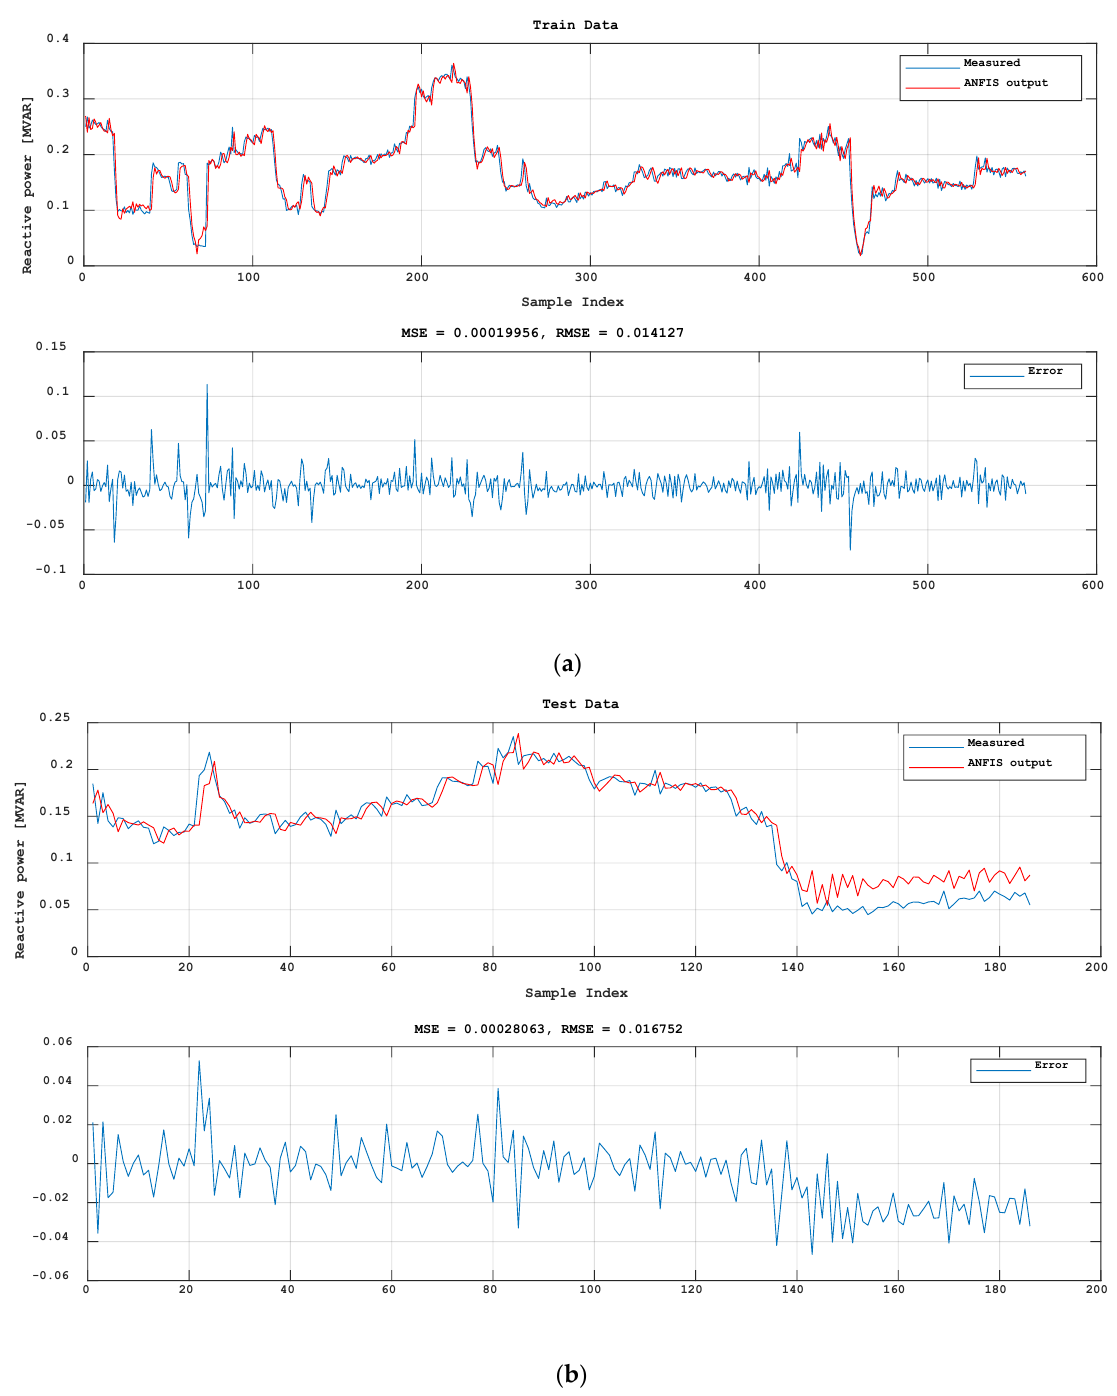
Figure 12. The variation in the measured and predicted reactive power and also of the error for modelling with ANFIS subtractive clustering method; ( a ) for training stage; ( b ) for testing stage.